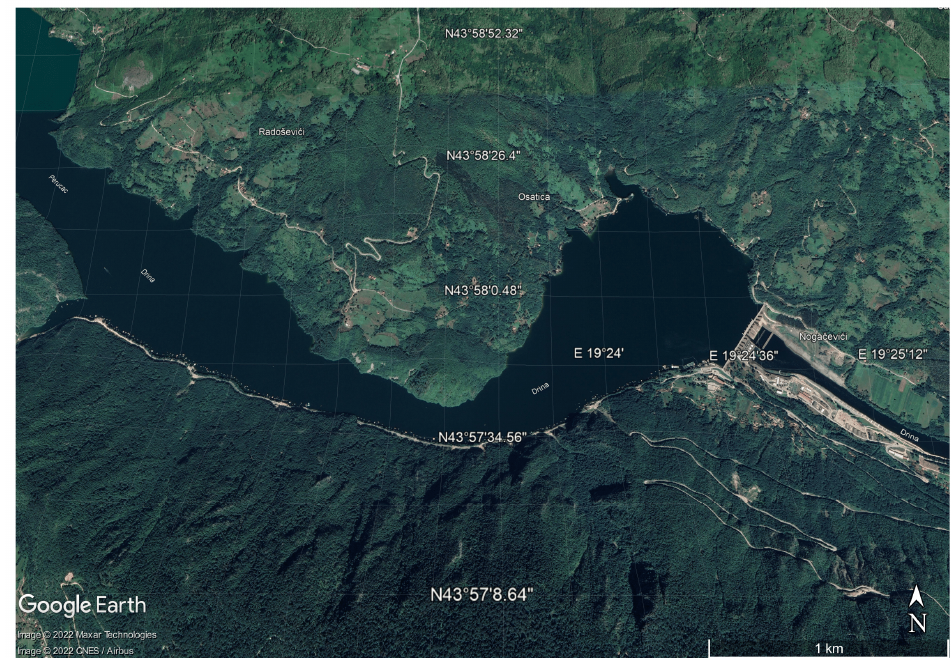
Figure 18. Heatmap of Drina River system after Bajina Basta hydroelectric dam near Peru ć ac, Serbia, from 5 January 2019 to 26 December 2021 (total 142 acquisitions). Basemap: multitemporal average of Sentinel ‐ 1 VV images. Colour: heatmap. (Sentinel ‐ 1, Credits: ESA).